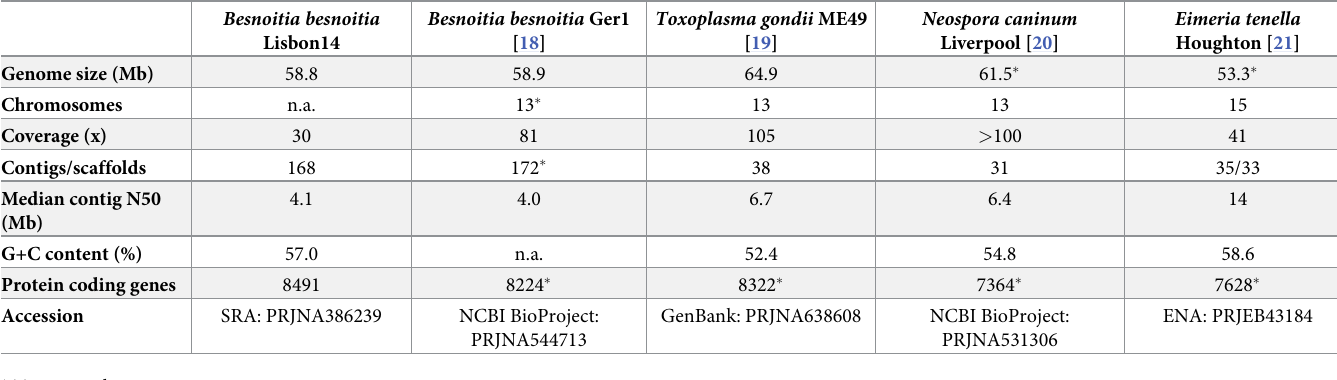
Table 1. Comparison of genome parameters from different